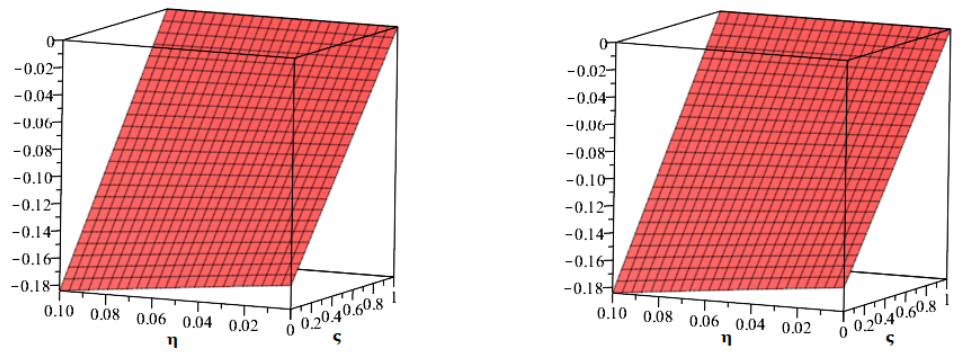
Figure 4. The proposed method solution and accurate solution at γ = 1.